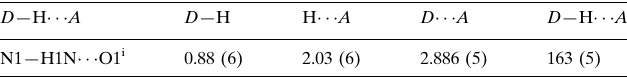
Hydrogen-bond geometry (A˚ , (cid:1)